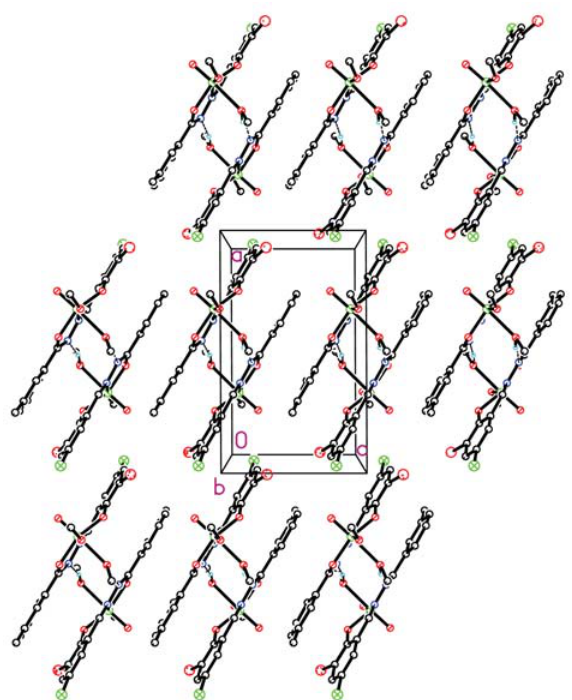
Figure 2. A perspective view of the dimeric structure of the